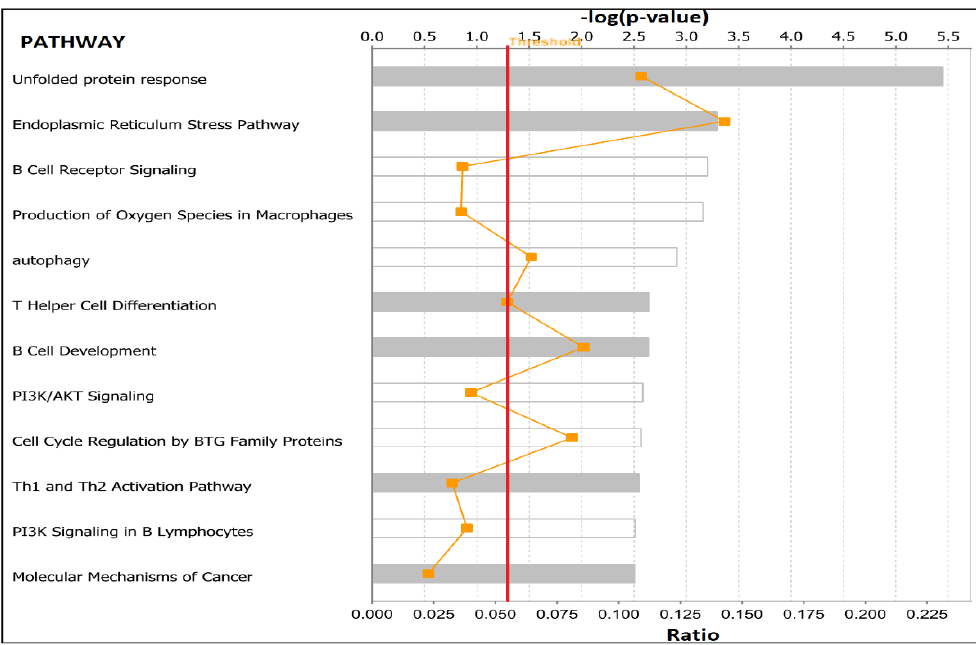
Figure 6. Biological pathways predicted to highly significantly associate obesity with TNBC in premenopausal women. The red line indicates the threshold level above which significance is declared. The zigzagging orange line denotes the ratio of the number of genes predicted to map to that pathway to the original number of genes in that pathway.